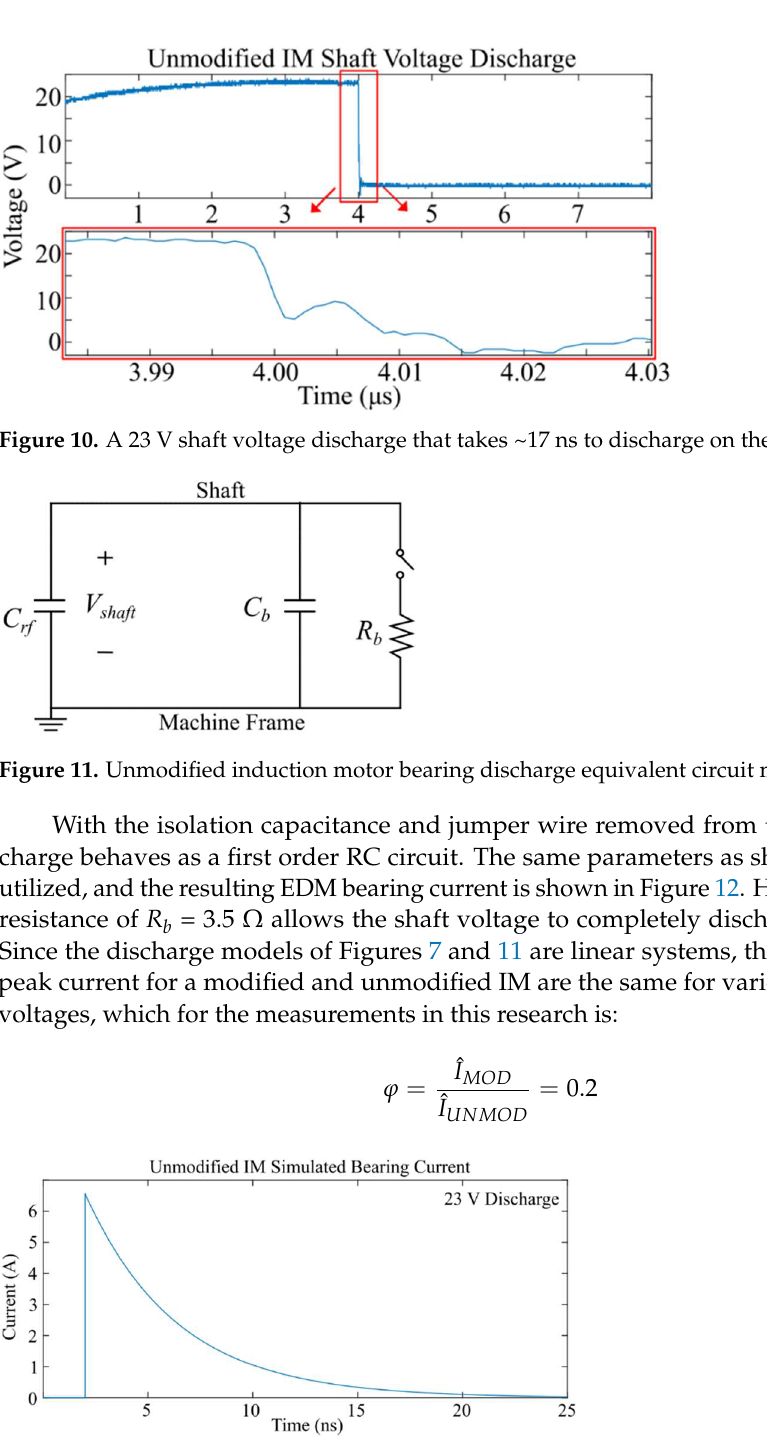
Figure 12. Simulated EDM bearing current for a 23 V shaft voltage discharge that dissipates in ~17